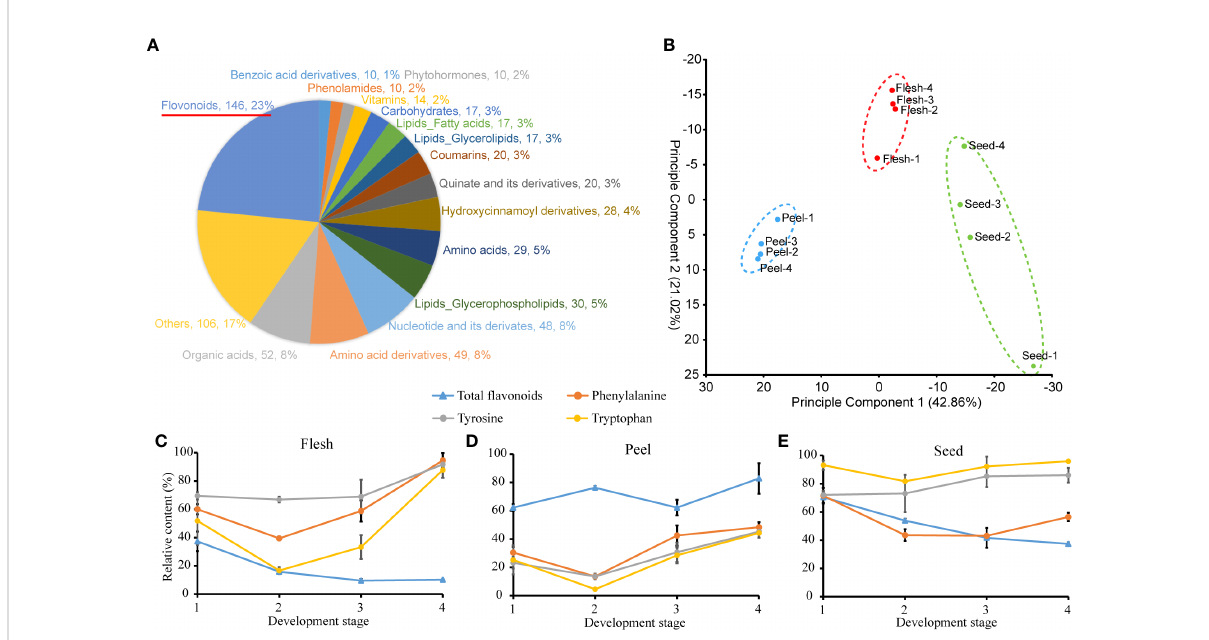
FIGURE 1 Metabolite measurements of fl esh, peel and seed tissues at 4 developmental stages. (A) Classi fi cation of metabolites. (B) Plot of principal component analysis of metabolite contents between 3 tissues and 4 development stages. (C – E) Relative contents of aromatic amino acids and total fl avonoids in different stages and tissues. The maximum content of the given metabolite among 36 samples is as